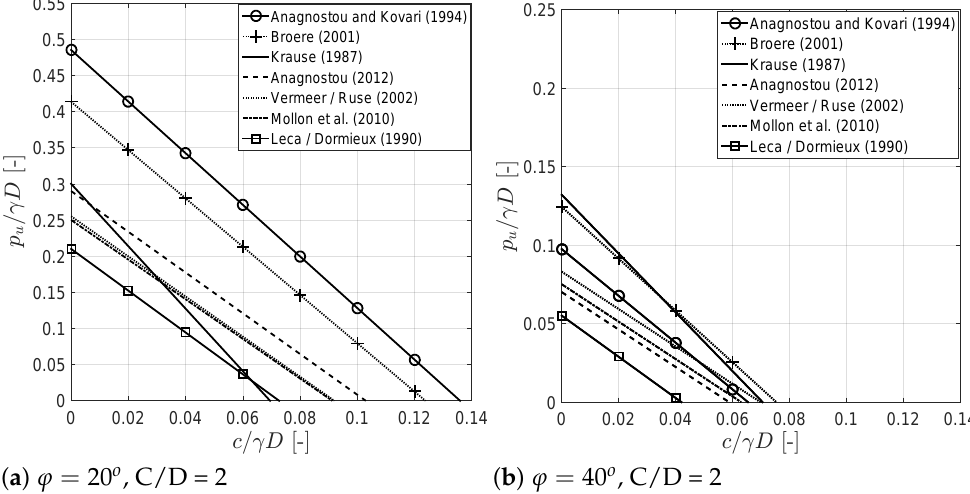
Figure 7. Normalized support pressure ( p u / γ D ) as a function of normalized cohesion ( c / γ D